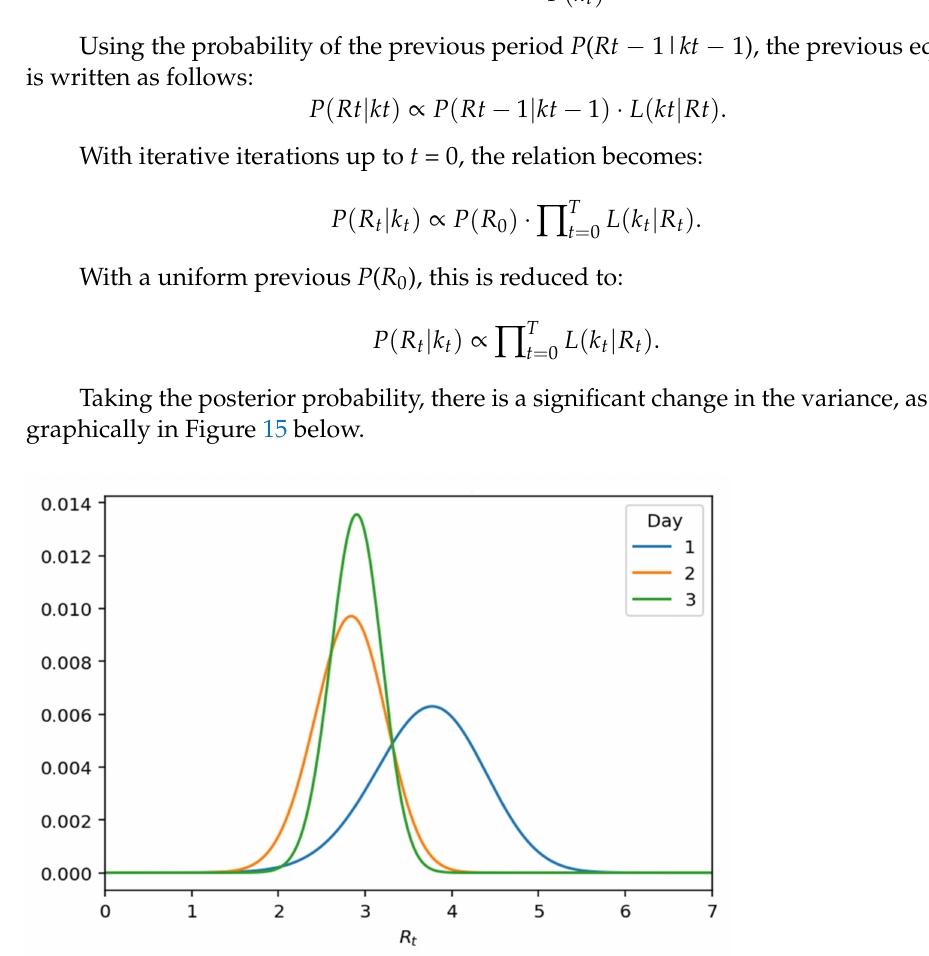
Figure 15. Posterior P ( R t | k )